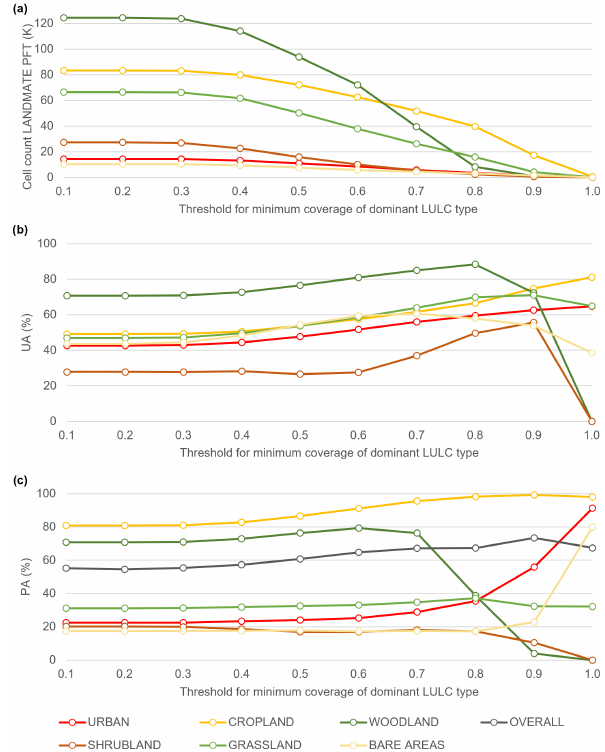
Figure 6. Cell count (a) , user’s accuracy (b) and producer’s ac- curacy (c) per LULC type of the LANDMATE PFT as a function of the threshold for minimum coverage of the respective dominant LULC